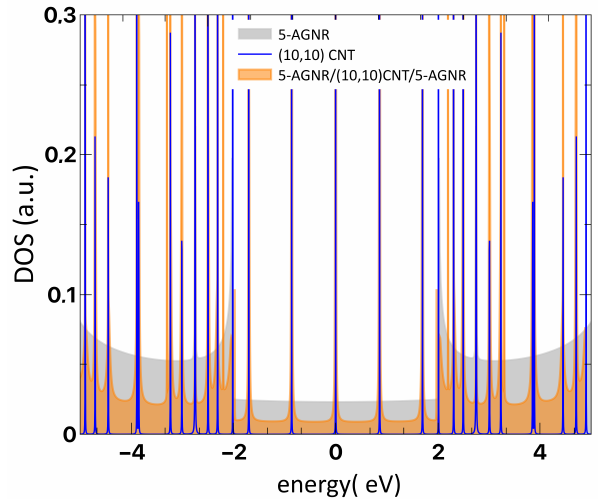
Figure 4. (Color online) DOS results for a 5-AGNR/(10,10)CNT/5-AGNR system, with n = 10 (shaded orange), for a single 5-AGNR (shaded gray), and for the finite isolated (10,10) CNT (blue